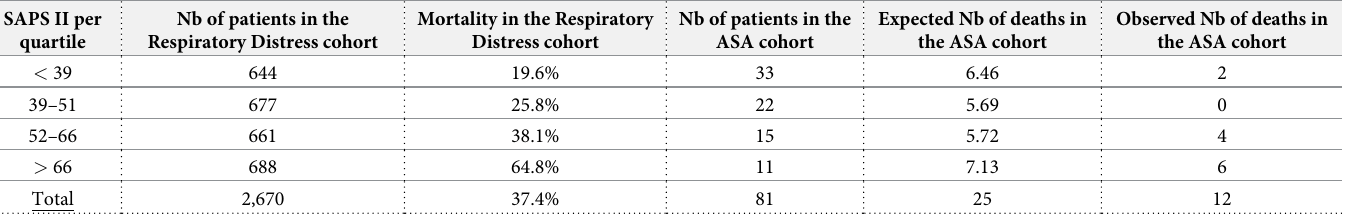
Table 3. Standardized mortality ratio of patients with acute severe asthma relative to the SAPSII compared to a reference population of patients with any type of respiratory distress. SAPS II per